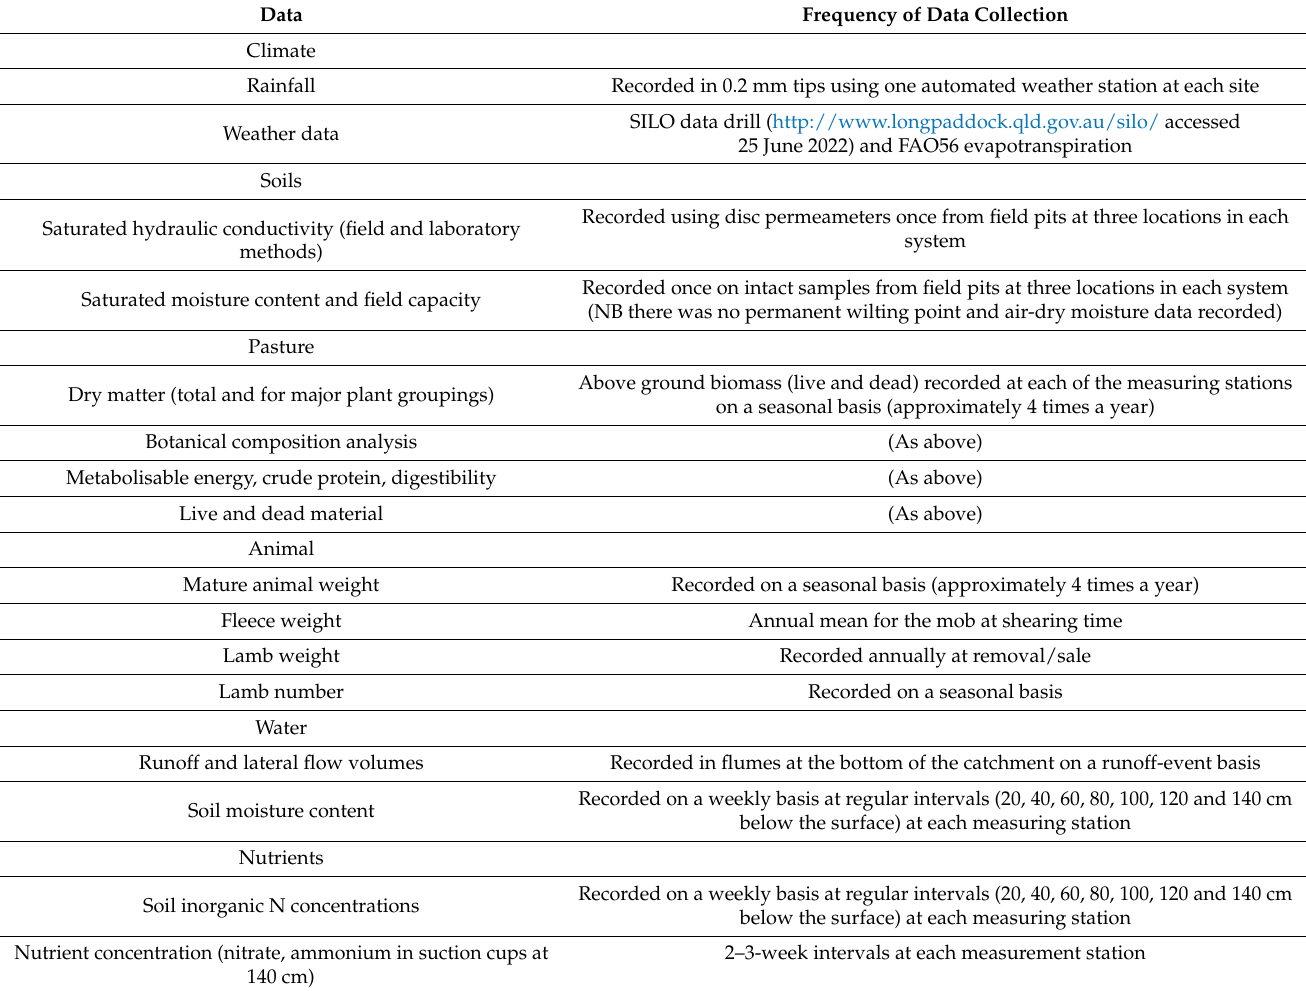
Table 1. Summary of experimental data used in the evaluation of the SGS Model (further details such as methods of measurement are shown in [24].